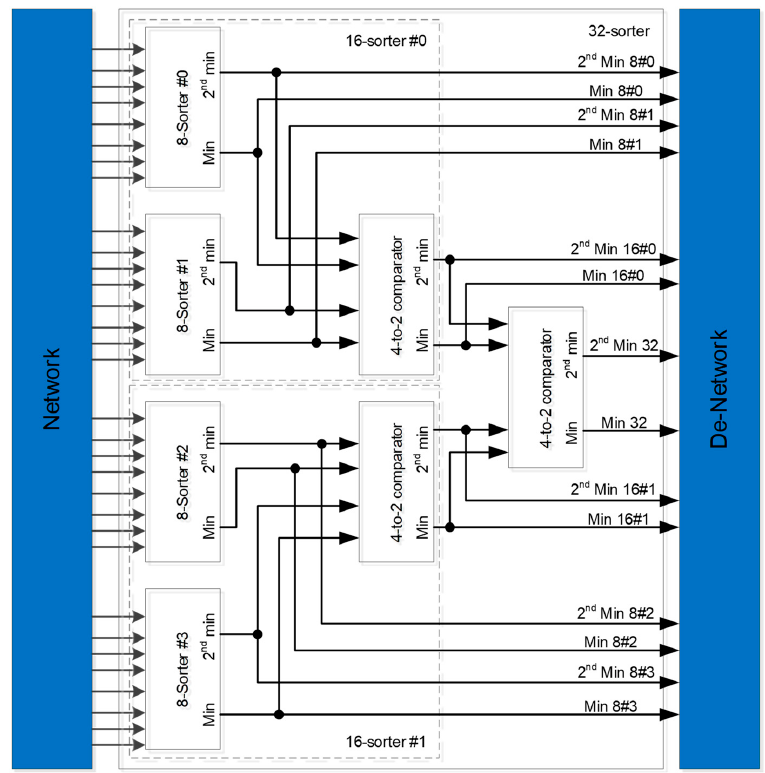
Figure 21. Reconfigurable 8/16/32 input sorter architecture.